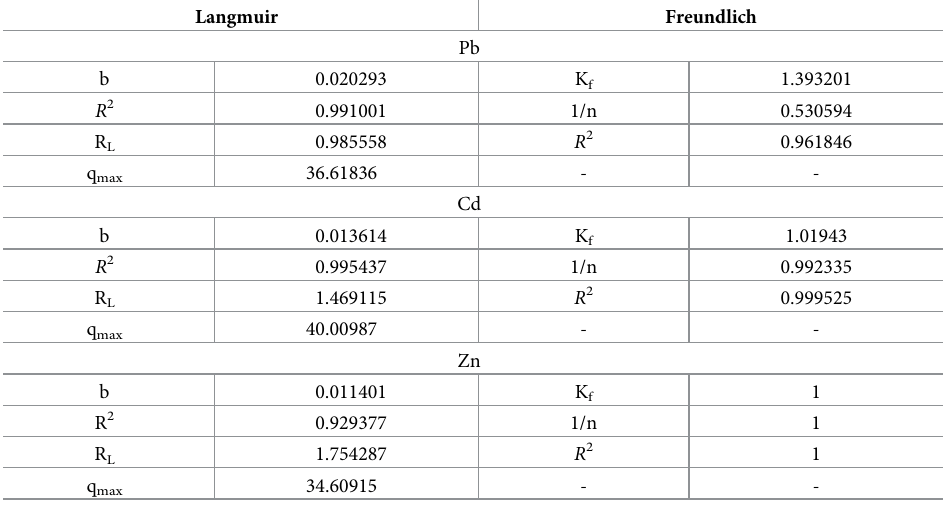
Table 2. Constants of Langmuir, Freundlich, isotherm. Langmuir Freundlich